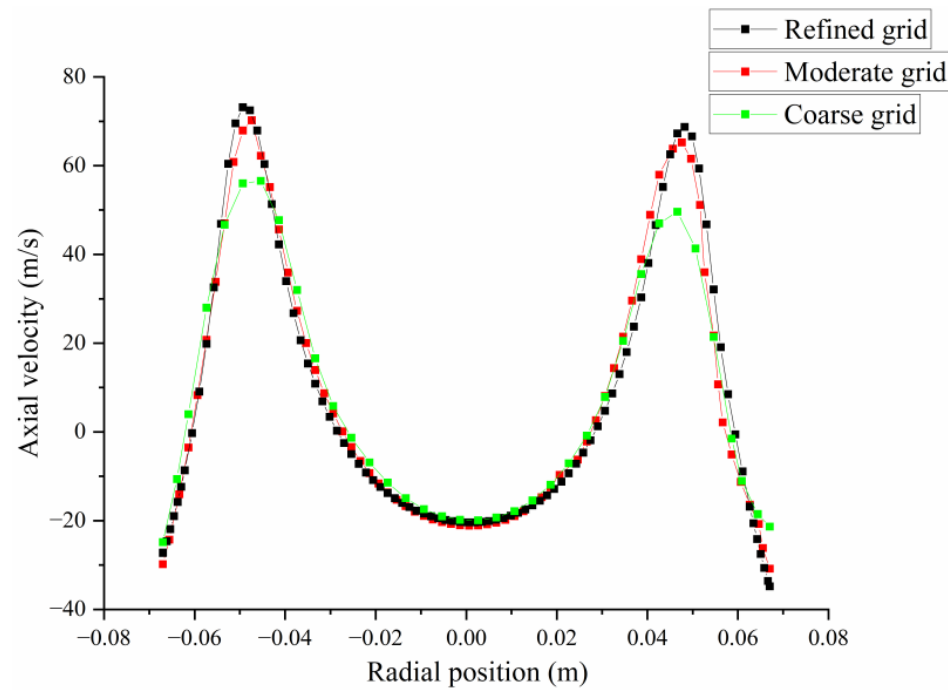
Figure 3. Grid independence verification for velocity.